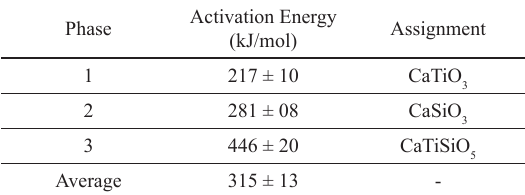
Table 3. Activation energies obtained by the Kissinger Method for Phase 1 (Curve 1), Phase 2 (Curve 2) and Phase 3 (Curve 3), crystallized after the heat treatment of Ca